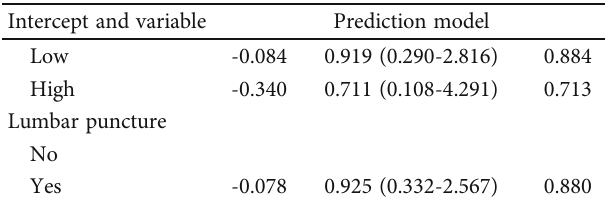
Table 3: Multivariable logistic regression analysis of the training